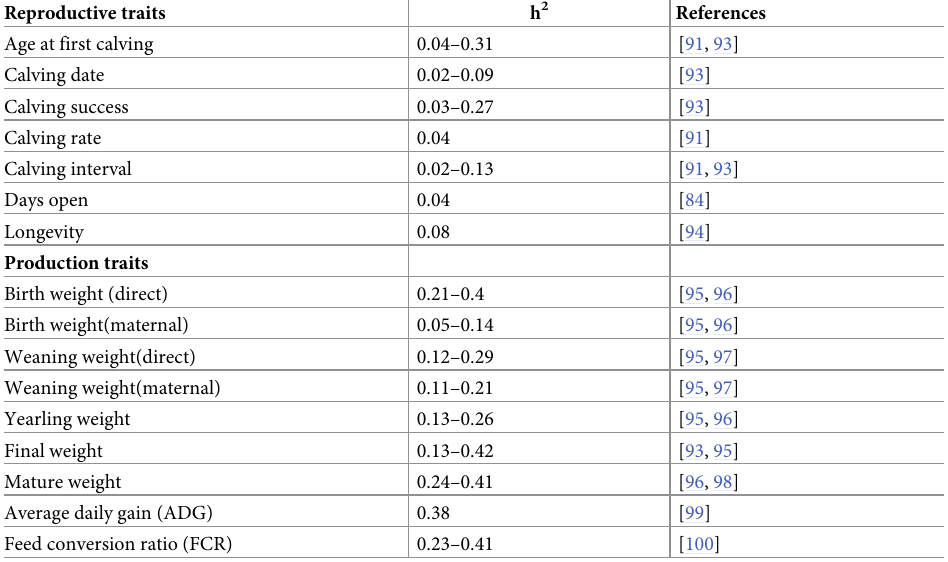
Table 6. Summary of ranges of heritability values for reproduction and production traits of Tropical cattle. Reproductive traits h